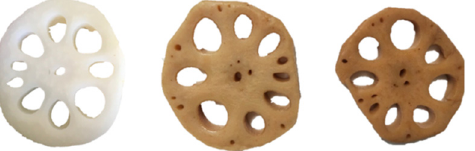
Figure 1. The appearance of blank ( left ), HPP ( middle ), and TS ( right ) marinated lotus root slices. HPP, high-pressure processing; TS,